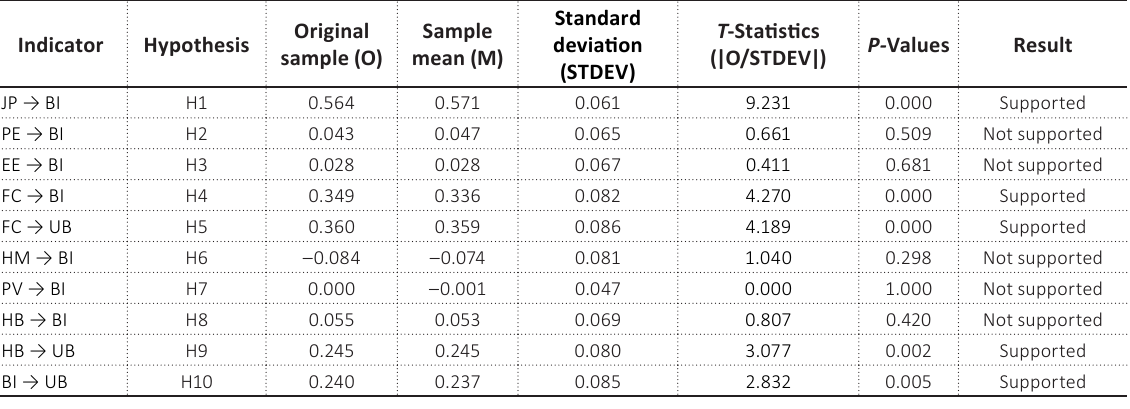
Table 5. Hypotheses testing